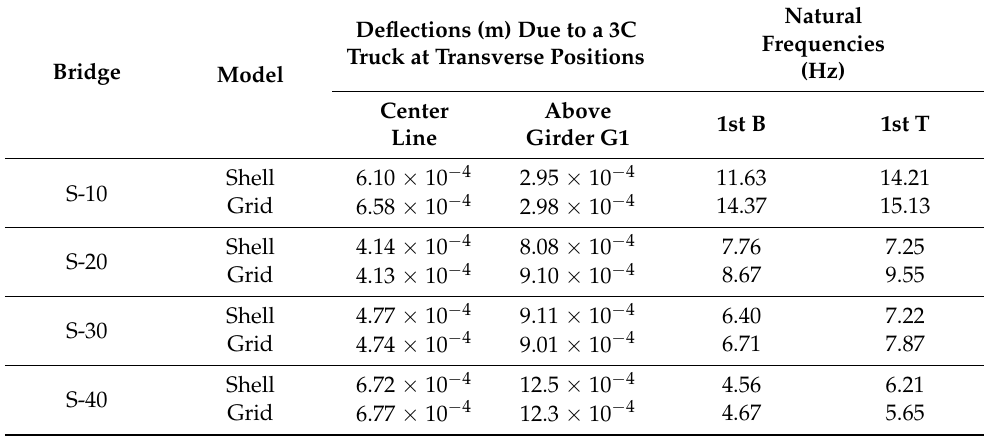
Table 3. Maximum deflections and natural frequencies from the grid model and shell model for simply supported bridges (B = bending; T =